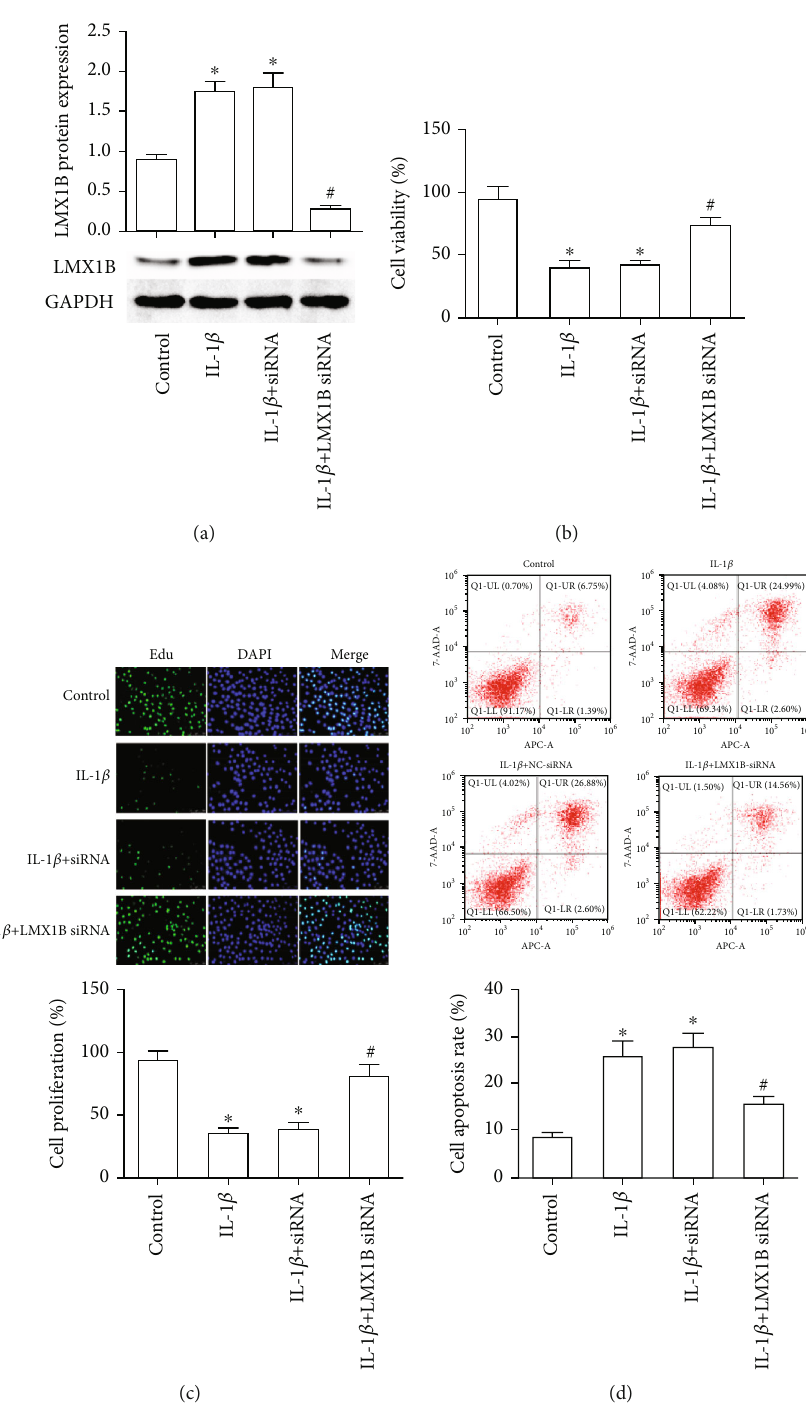
Figure 3: LMX1B knockdown increased IL-1 β -induced C28/I2 cell growth and suppressed its apoptosis. (a) Western blot analysis for LMX1B protein expression; (b) CCK-8 analysis for C28/I2 cell survival; (c) 5-ethynyl-2 ′ -deoxyuridine (EdU) assay was used to determine C28/I2 cell proliferation; (d) C28/I2 cell apoptosis was detected by using fl ow cytometer analysis. C28/I2 cells were transfected with control siRNA or LMX1B siRNA for 24h by using Lipofectamine 2000 reagent and then treated with 10ng/ml IL-1 β for 24 h. ∗ P < 0 : 05 , compared with the control group; # P < 0 : 05 , compared with the IL-1 β group. All experiments were repeated three